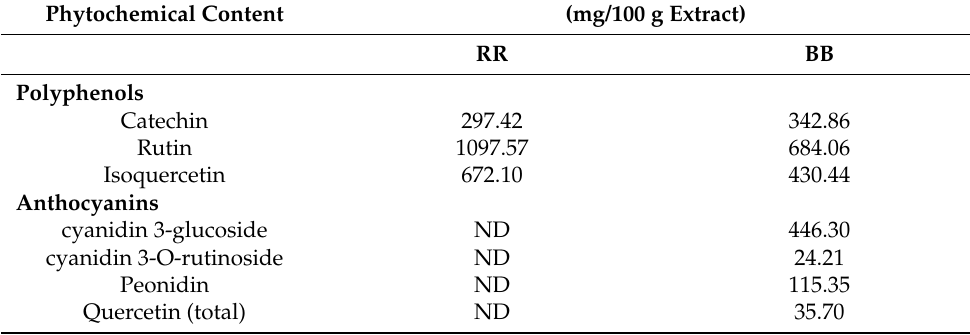
Table 1. Phytochemical content in RR and BR ethanolic